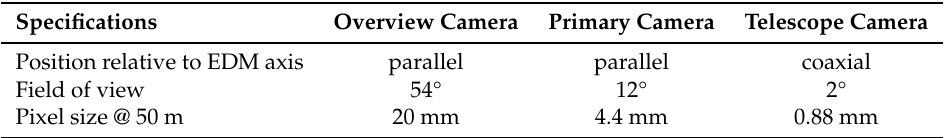
Table 2. Some specifications of Trimble SX10 on-board cameras according to